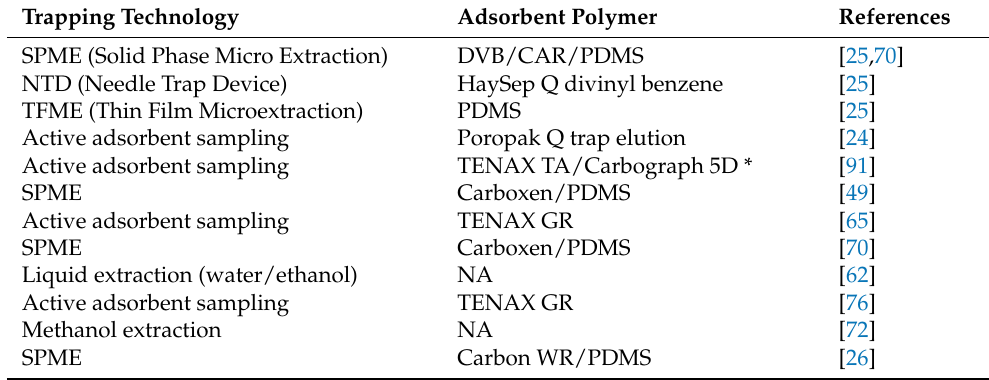
Table 2. Various trapping methods used for bed bugs’ VOCs